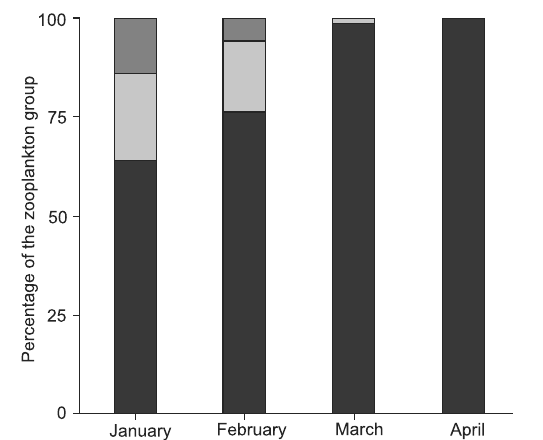
Figure 1. Zooplankton composition in the stomach contents from Oreochromis niloticus each month. ( (cid:132) ) Copepoda, ( (cid:132) ) Cladocera, ( (cid:132) ) Rotifera.